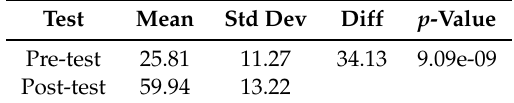
Table 3. The t -test analysis result of pre-test and post-test scores of students in the experiment group. Test Mean Std